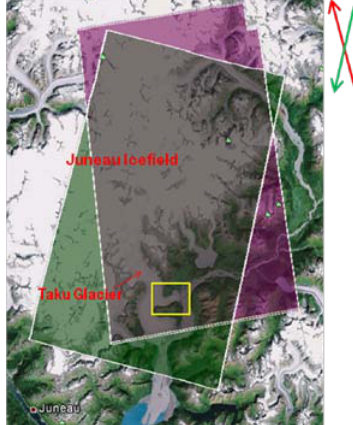
Fig.2. Ground coverage of geo-coded SAR data plotted on an optical image of the scene. Red arrow: azimuth direction of ascending orbit; Green arrow: azimuth direction of descending orbit. In both tracks, TerraSAR-X is right looking. Yellow box: area used for experiment. (Underlying optical image ©2013 Google Earth)